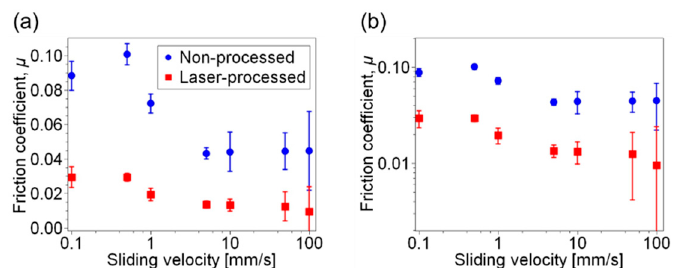
Figure 3. The friction coefficient as a function of the sliding velocity in the cases of non-processed and laser-processed gel surfaces. The vertical axes are ( a ) linear and ( b ) logarithmic scales (mean ± standard deviation).